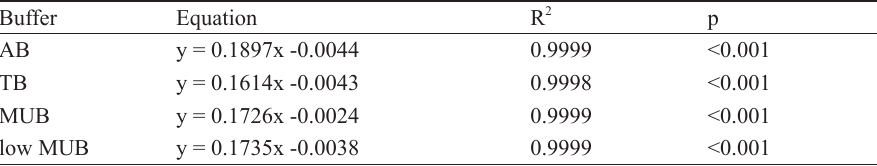
Parameters of equation used to estimate the p-NP of standard curves in each buffer 1